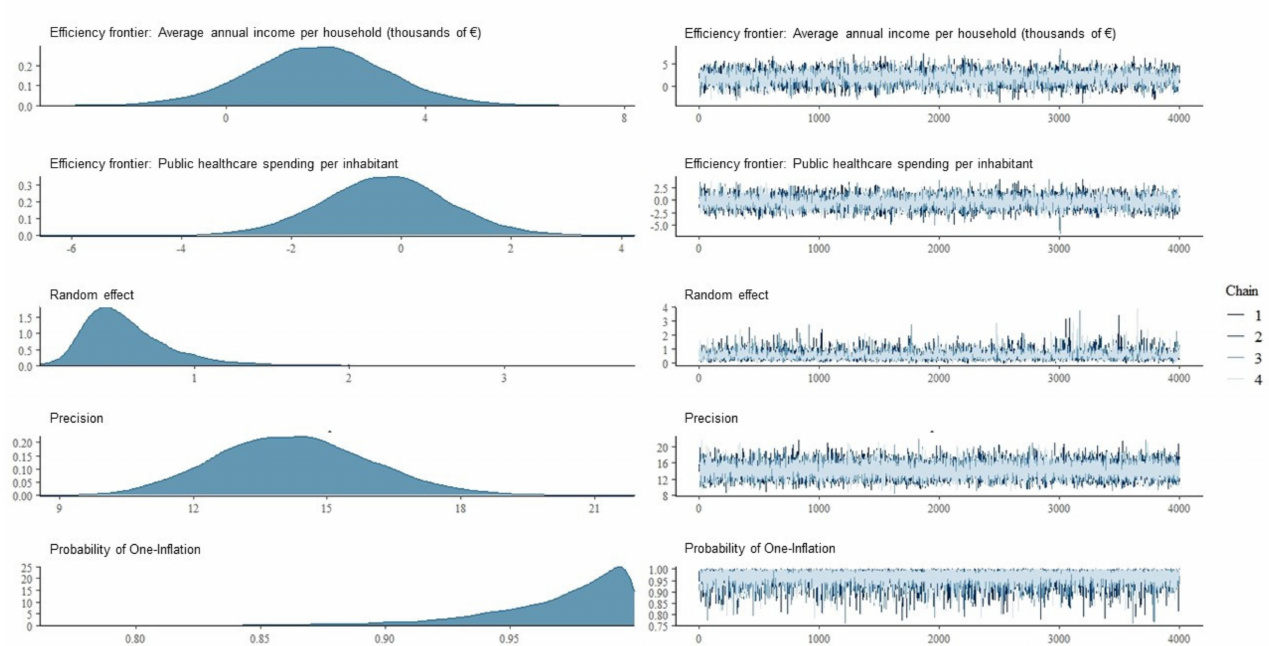
Figure A1. Posterior distribution function of the coefficient of each standardized variable. Variable names starting with “Efficiency” correspond to the distribution of the coefficients in the modelling of the Mean Efficiency Index (MEI). Variable names start-ing with “Efficiency frontier” correspond to the distribution of the coefficients in the mod-elling of the odds of being placed on the efficiency